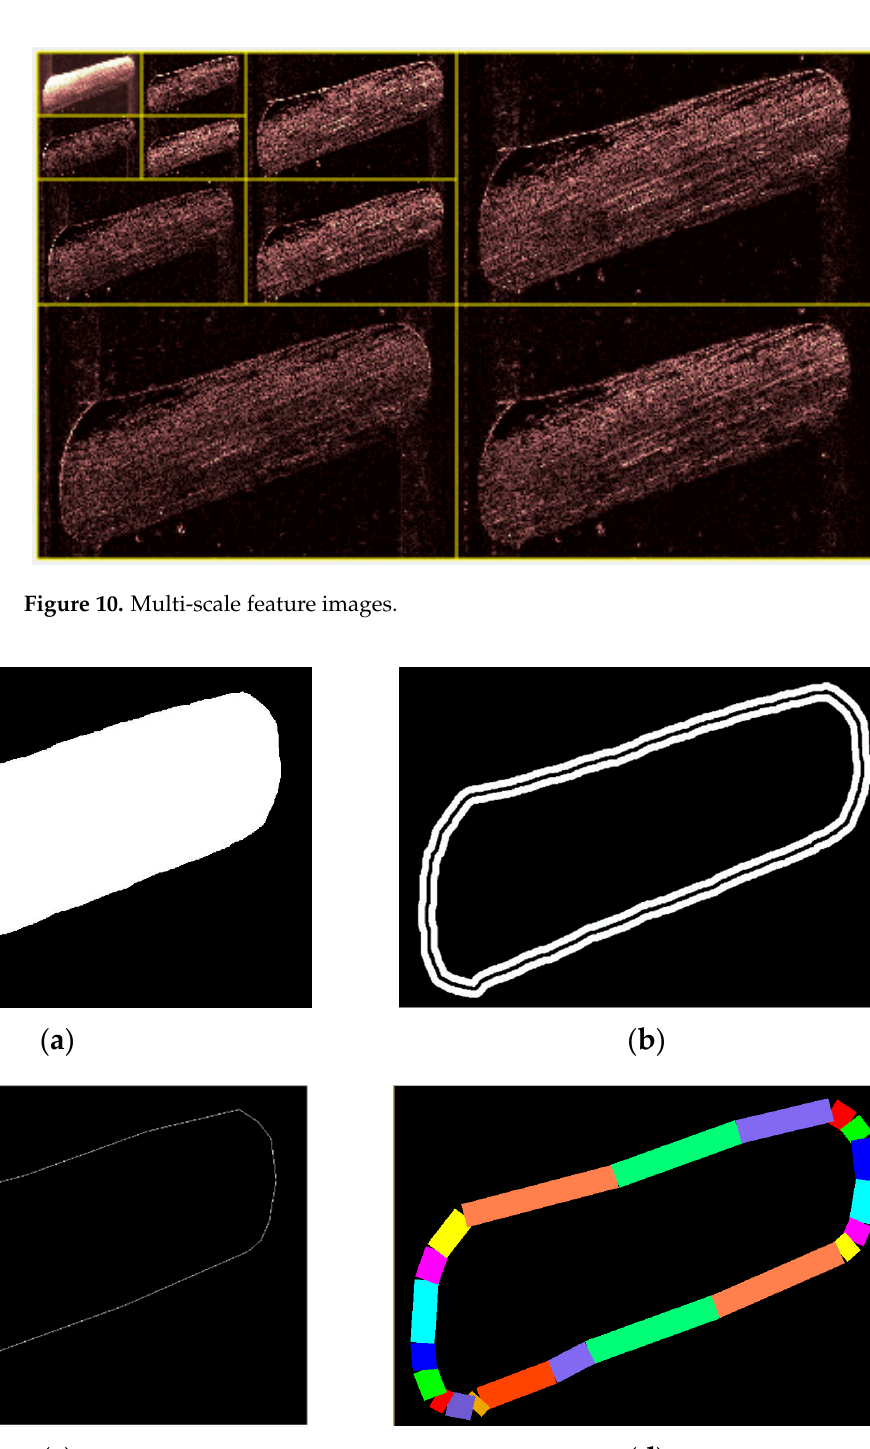
Figure 9. Standard segmented image.